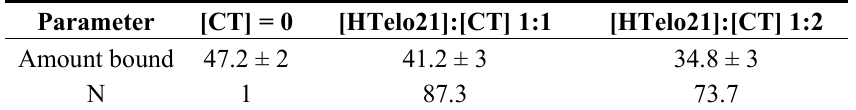
Table 3. Competition experiments on HTelo21 oligo. Values of percentage bound DNA as derived from Equation 7 (see Experimental 3.4) for samples containing a fixed amount of both drug and G-quadruplex DNA (5 μ M, 1:1 ratio) and different amounts of calf thymus DNA (CT), at the indicated quadruplex/duplex ratios (in phosphate ions). N is the normalized percentage of bound quadruplex, defined as follows: N = (% quadruplex bound in presence of CT)/(% quadruplex bound in absence of CT).